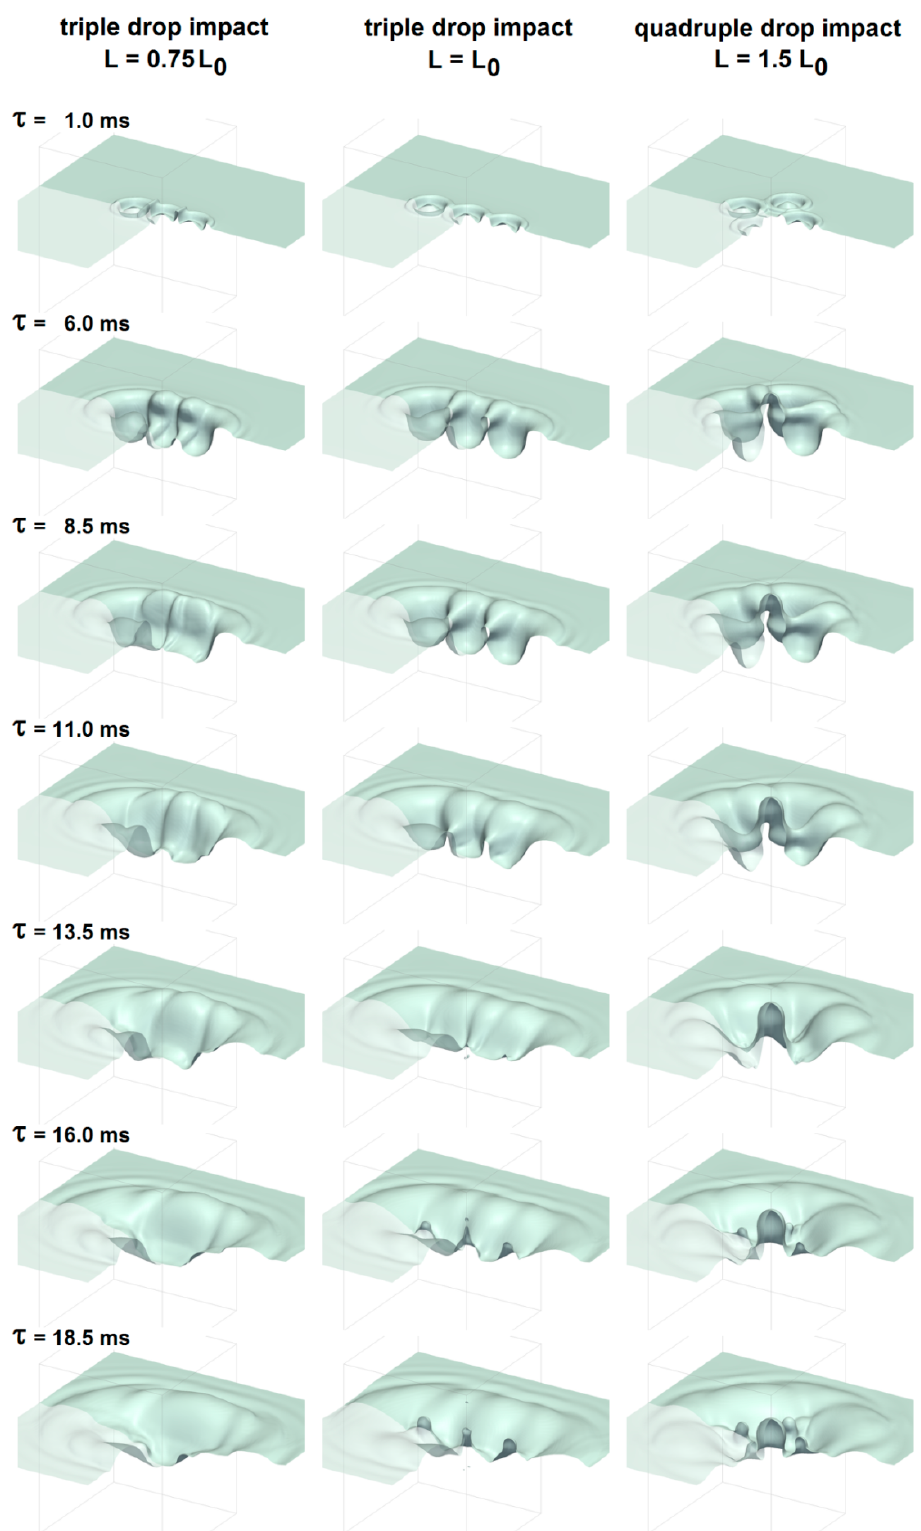
Figure 12. Rendering of some frames showing the crater evolution from the simulations of three-drop and four-drop cases (w = 1.4 m/s).